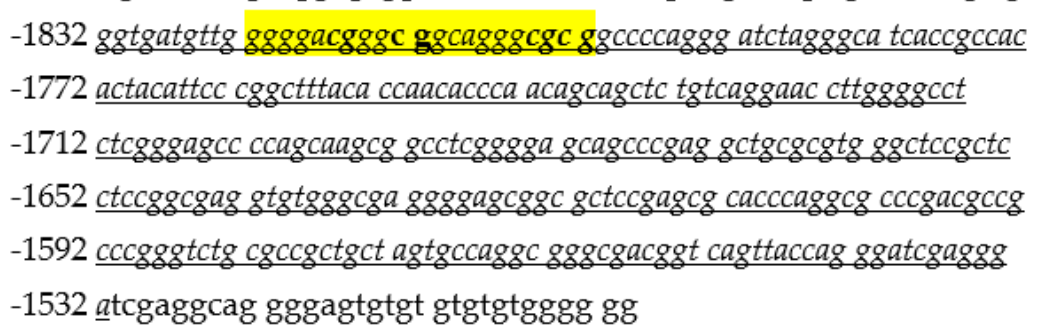
Figure 1. Sequence of the ( − 1843/ − 1533) region (italic, underlined) including the 4 investigated CpG sites (bold).